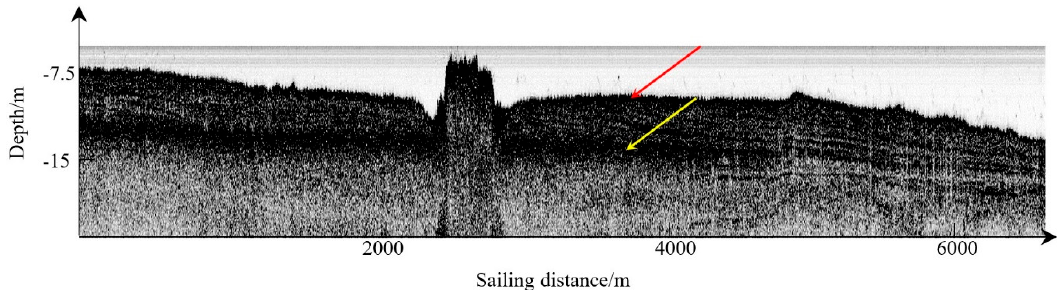
Figure 8. The built SBP image using a low ub value. The red arrow points to the seafloor, while the yellow arrow points to the sub seafloor sediment interface.